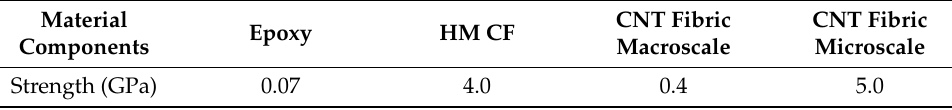
Table 2. Strength of material components.